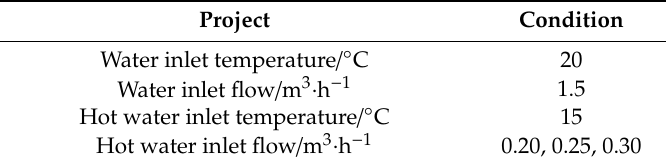
Table 3. Experimental test condition.